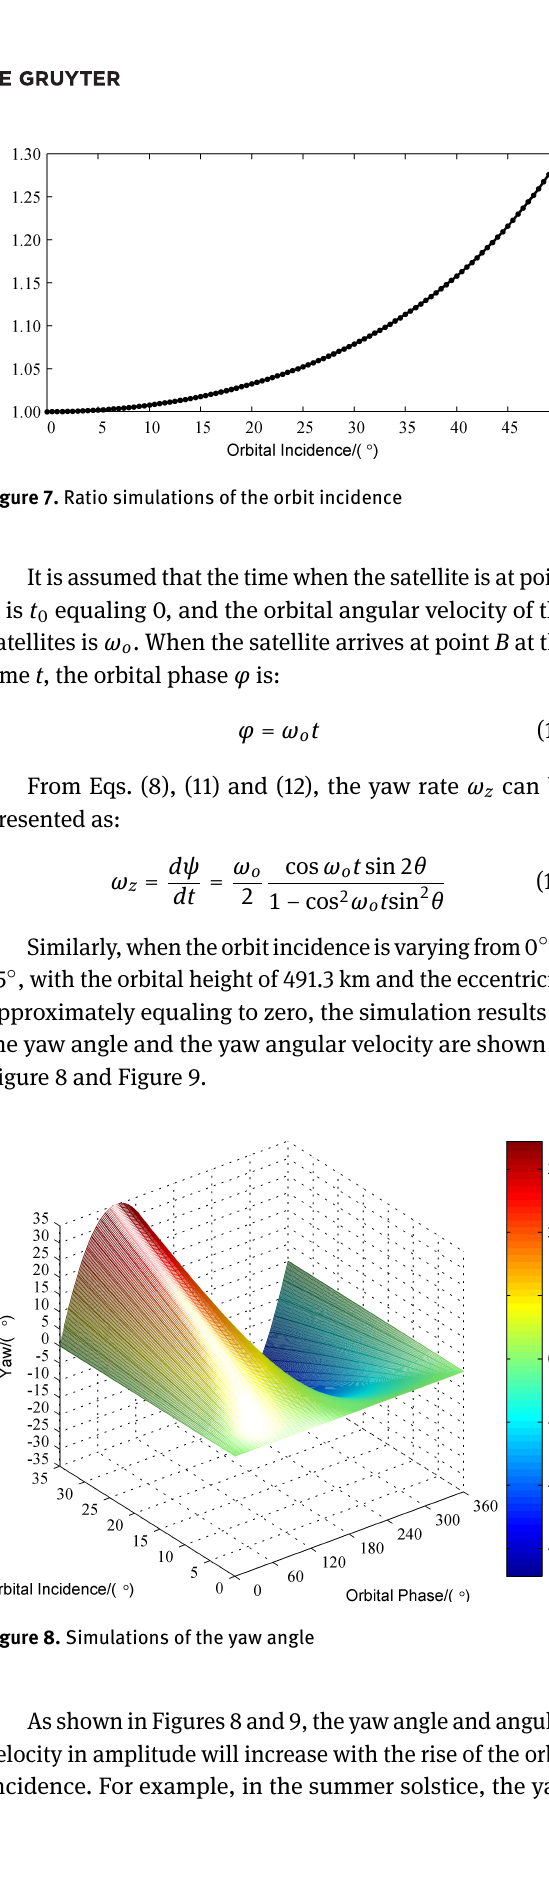
As shown in Figures 8 and 9, the yaw angle and angular velocity in amplitude will increase with the rise of the orbit incidence. For example, in the summer solstice, the yaw